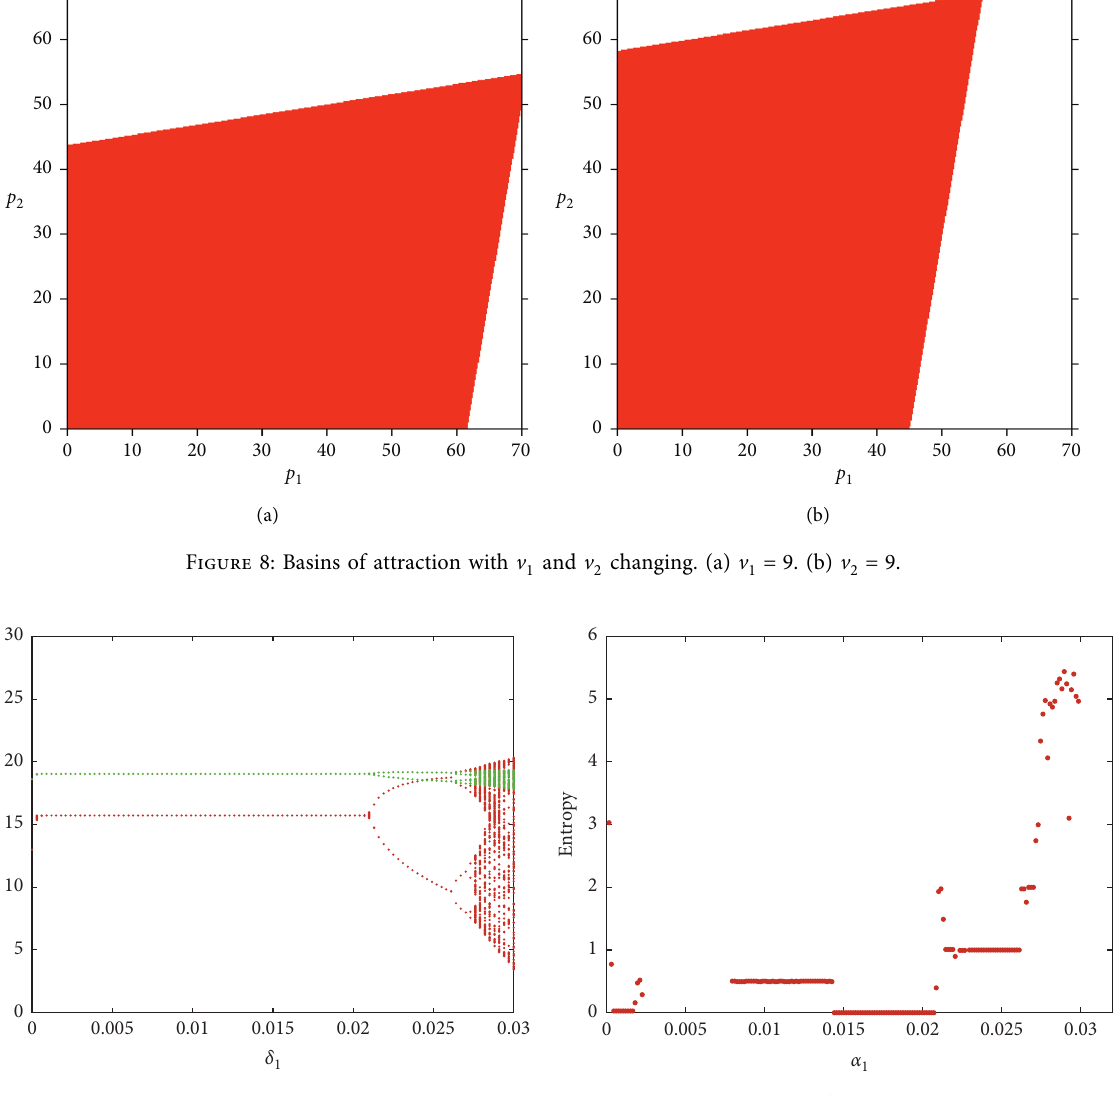
varying. (a) The price bifurcation. (b) 1